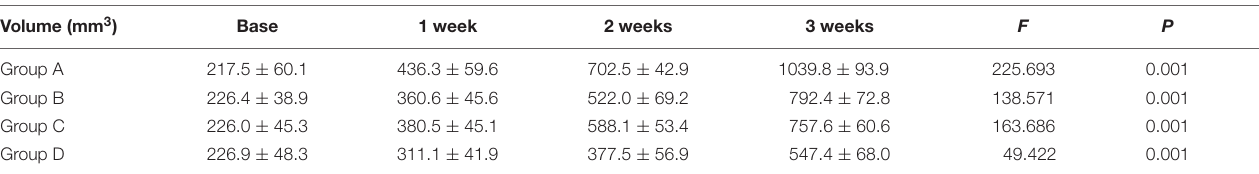
FIGURE 1 | Characterization of cRGD-PLGA@DOX nanoparticles. Transmission electron micrographs of PLGA-PEI-mPEG nanoparticles (A) and cRGD-PLGA@DOX nanoparticles (B) . The stability examination of the nanoparticle system in PBS and human serum with 3 days (C) . The average sizes of PLGA, PLGA-PEI-mPEG, and cRGD-PLGA@DOX copolymers, respectively (D) . The zeta potentials of PLGA, PLGA-PEI-mPEG, PLGA-cRGD, and cRGD-PLGA@DOX, respectively (E) . The DOX-release behavior of cRGD-PLGA@DOX at pH 7.4, 6.0, and 5.3 in different time points (F) . IC50 values of A549 and HeLa cancer cells at a DOX concentration ranging from 0.125 to 8 µ M (G) . * P < 0.05 and *** P < 0.001. TABLE 1 | The tumor volume at different time points from the four